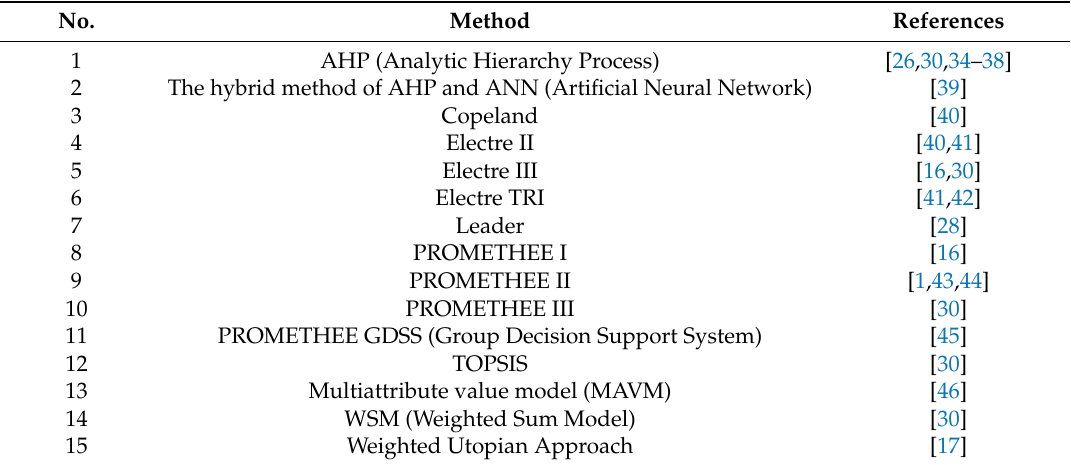
Table 1. Multi-criteria analysis methods used in the field of water distribution networks.